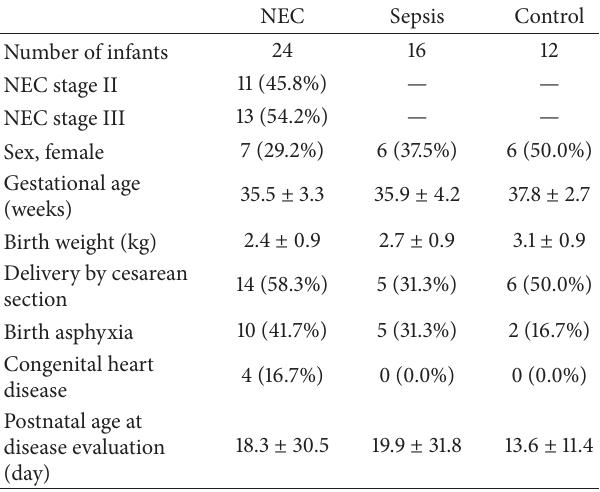
Table 1: Patients’ demographics. The data are expressed as number of cases (%) or mean ± standard